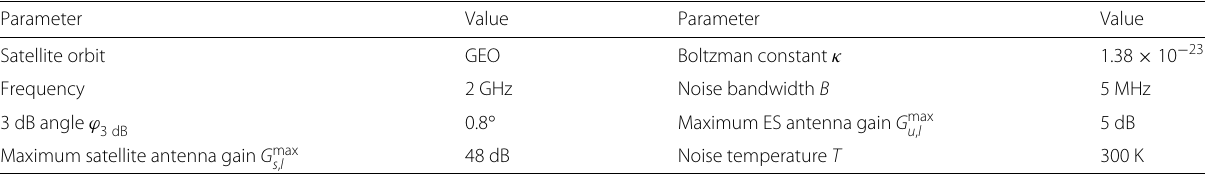
Table 1 Simulation parameters